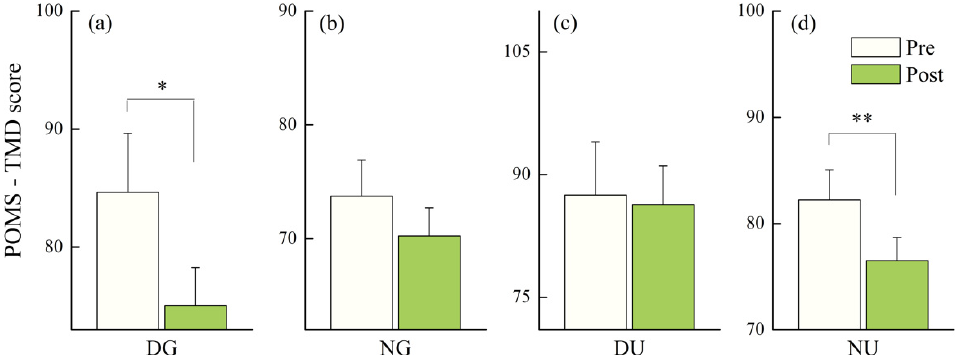
Figure 5. Outcomes of POMS-total mood disturbance (TMD) in: ( a ) daytime green walking; ( b ) nighttime green walking; ( c ) daytime urban walking; and ( d ) nighttime urban walking. The error bar represents standard error, and * represents p < 0.05, ** represent p < 0.01. Analyzed using Wilcoxon signed-rank test ( N = 12).